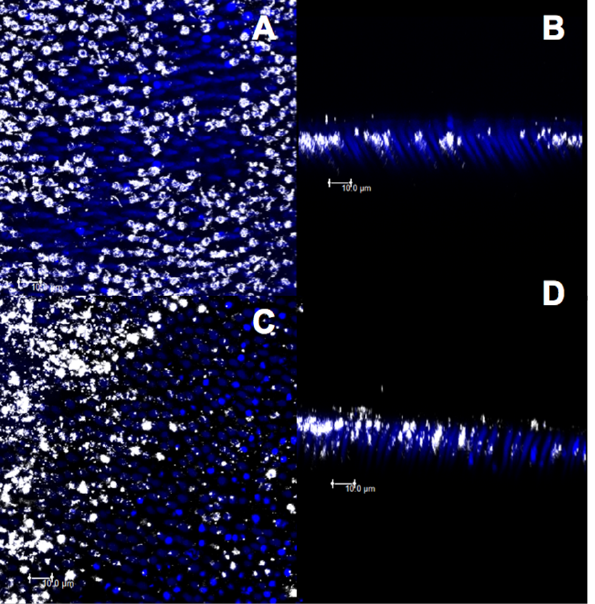
Figure 8. Confocal laser scanning microscopy images (fluorescence mode) in XY and XZ axis of dentin surface. ( A , B ) Adhesive without nanofiber and ( C , D ) after 6% citric acid challenge.